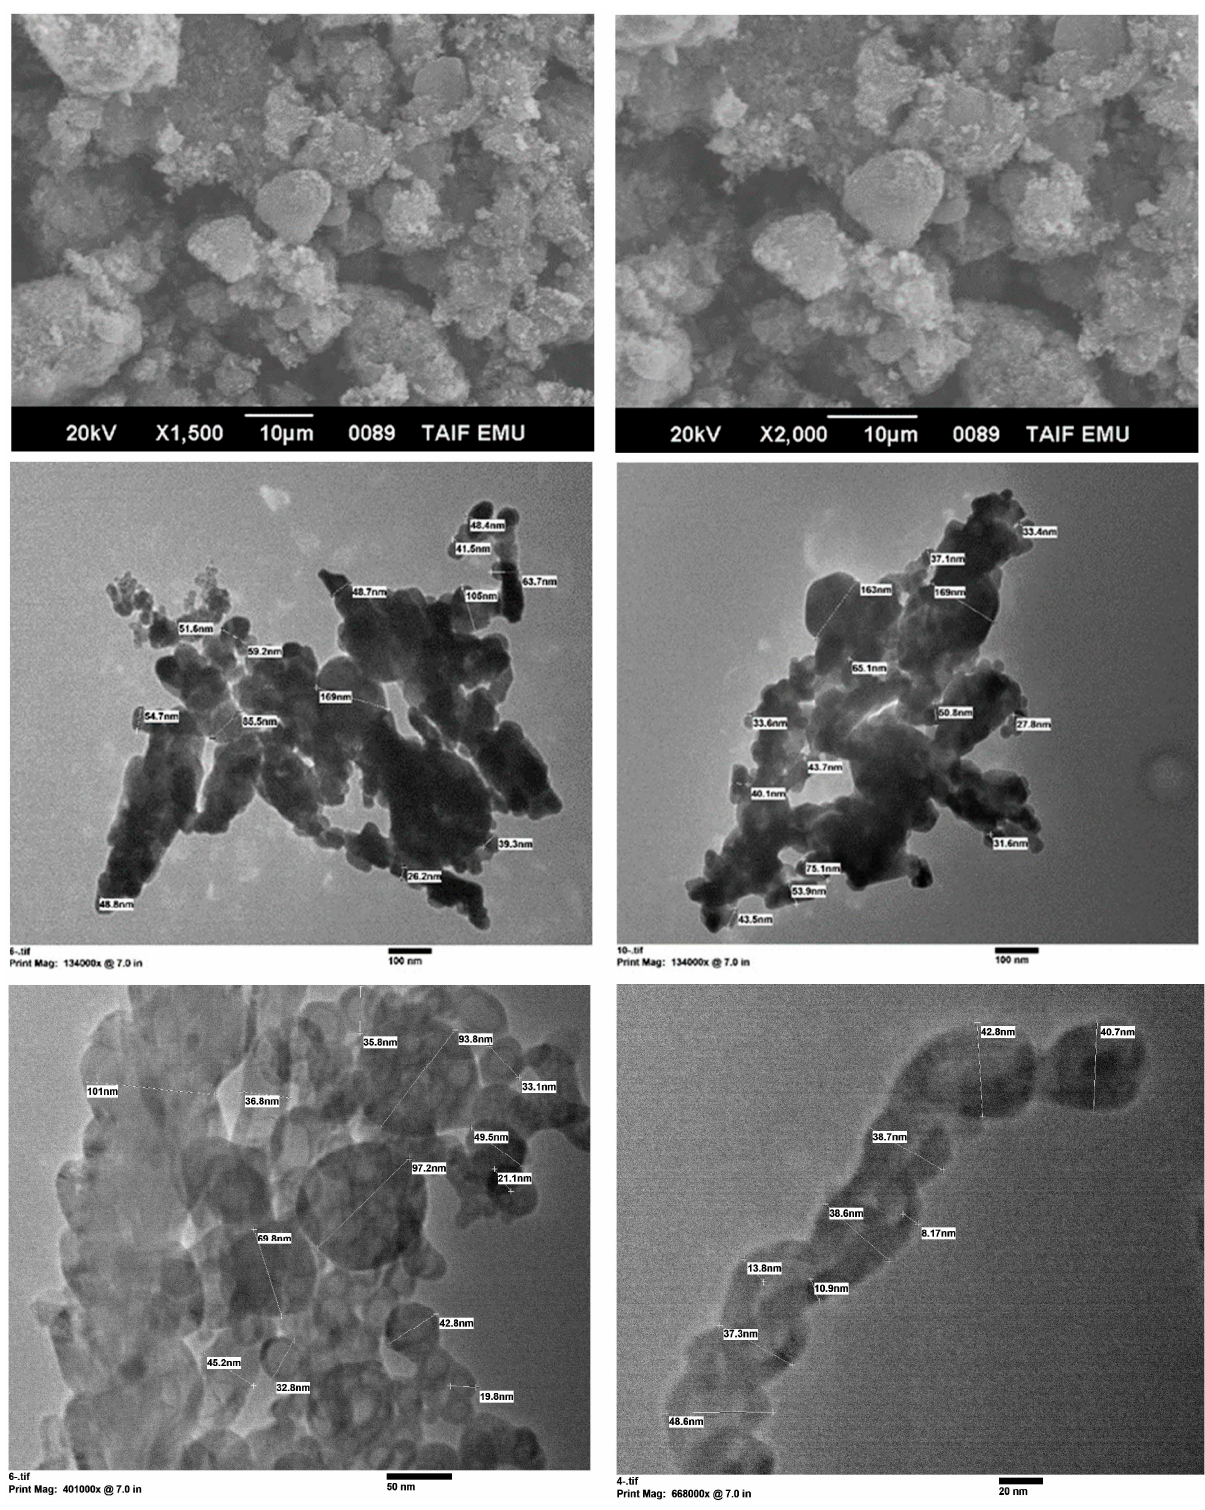
Figure 6. SEM and TEM micrographs of the fabricated adsorbent material.